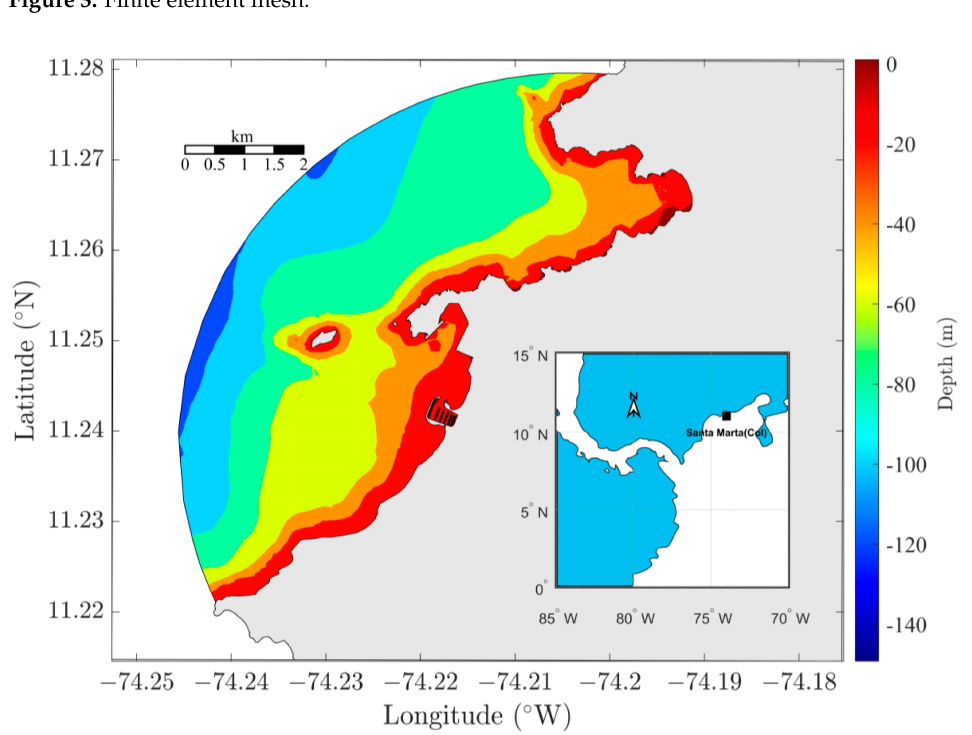
Figure 4. Interpolated bathymetry in the simulation domain.